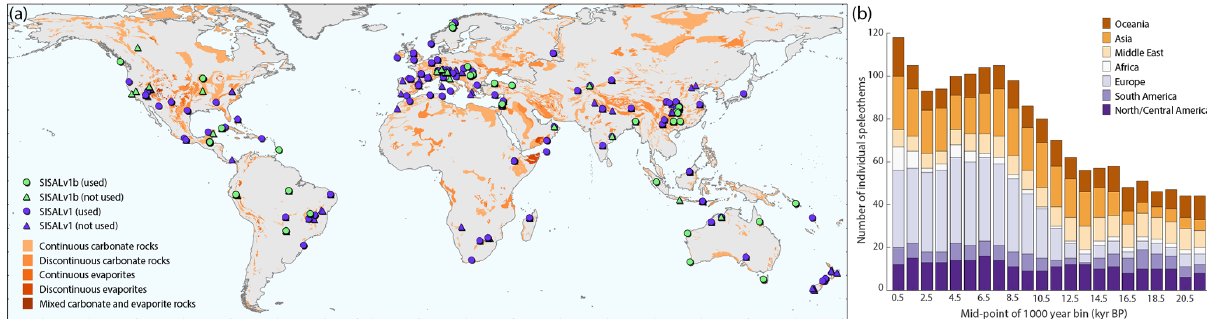
Figure 1. Spatio-temporal distribution of SISALv1b database. (a) Spatial distribution of speleothem records. Filled circles are sites used in this study (SISALv1 in blue; SISALv1b in green). Triangles are SISAL sites that do not pass the screening described in Sect. 2.3 and/or do not cover the time periods used here (modern, MH and LGM). The background carbonate lithology is that of the World Karst Aquifer Map- ping (WOKAM) project (Chen et al., 2017). (b) Temporal distribution of speleothem records according to regions. The non-overlapping bins span 1000 years and start in 1950CE. Regions have been defined as follows: Oceania ( − 60 ◦ < lat < 0 ◦ ; 90 ◦ < long < 180 ◦ ); Asia (0 ◦ < lat < 60 ◦ ; 60 ◦ < long < 130 ◦ ); Middle East (7 . 6 ◦ < lat < 50 ◦ ; 26 ◦ < long < 59 ◦ ); Africa ( − 45 ◦ < lat < 36 . 1 ◦ ; − 30 ◦ < long < 60 ◦ ; with records in the Mid- dle East region removed); Europe (36 . 7 ◦ < lat < 75 ◦ ; − 30 ◦ < long < 30 ◦ ; plus Gibraltar and Siberian sites); South America ( − 60 ◦ < lat < 8 ◦ ; − 150 ◦ < long < − 30 ◦ ); North and Central America (8 . 1 ◦ < lat < 60 ◦ ; − 150 ◦ < long < − 50 ◦ ).